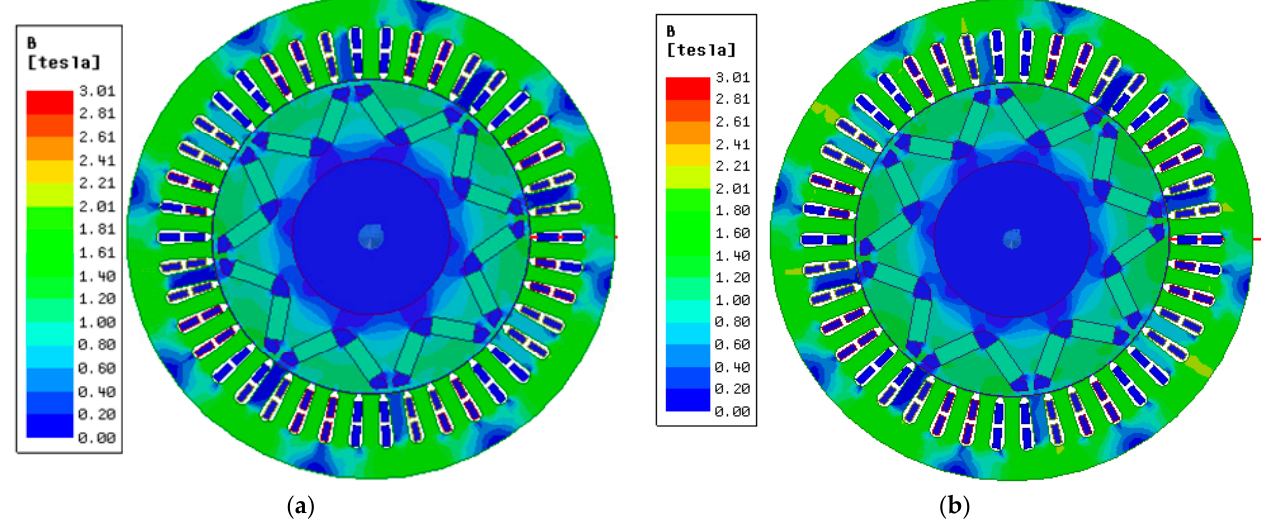
Figure 13. Magnetic flux density distribution. ( a ) Unidirectional coupling; ( b ) bidirectional coupling.